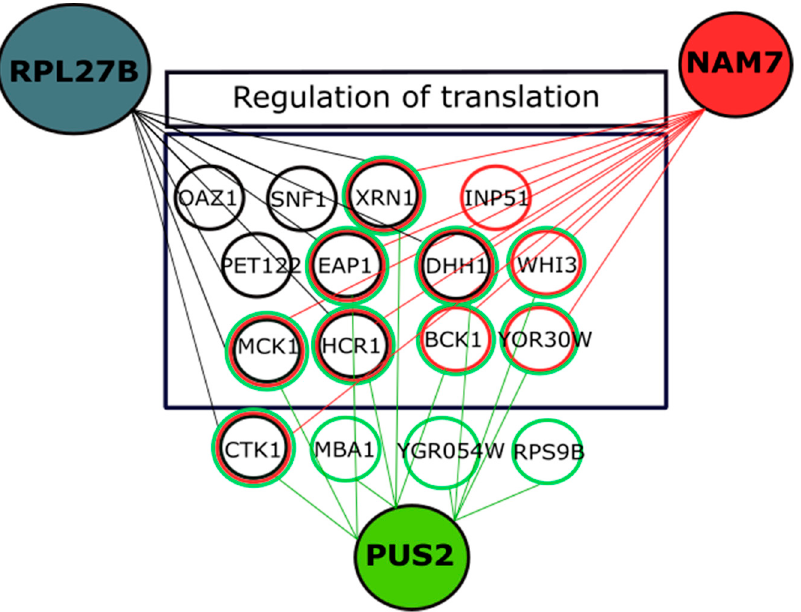
Figure 7. Conditional nGIs for NAM7 , PUS2 , and RPL27B under 3 mM concentration of LiCl. Our data shows a mutual Gene Ontology (GO) term enrichment for translation regulation genes for NAM7 ( p = 0.00037), PUS2 ( p = 1.1 × 10 − 6 ), and RPL27B ( p = 1 × 10 − 6 ). BCK1 , MCK1 , CTK1 , EAP1 , XRN1 , and DHH1 are mutual nGIs between the three quarry genes. Circles represent genes and lines represent nGIs identified in this study.